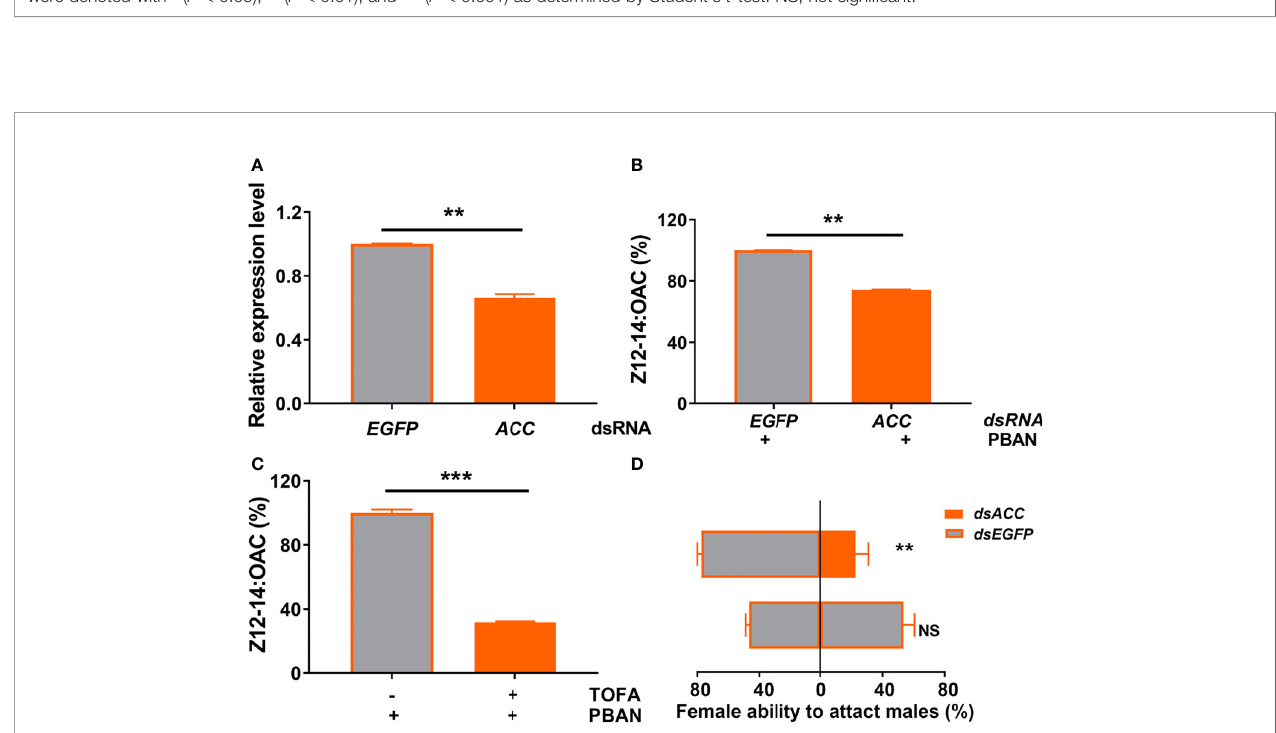
FIGURE 5 | ACC positively regulates sex pheromone biosynthesis in O. furnacalis PGs. (A) The effects of dsRNA injection on the expression of ACC transcript. (B) Effect of ds ACC knockdown on sex pheromone production in O. furnacalis PGs. (C) Effect of the ACC inhibitor TOFA on sex pheromone production in O. furnacalis PGs. (D) Effect of ds ACC knockdown on female capability to attract males. Data represent the mean ± SE (n = 3). Statistically signi fi cant differences were denoted with ** ( P < 0.01) and *** ( P < 0.001) as determined by Student ’ s t -test. NS, not signi fi cant.